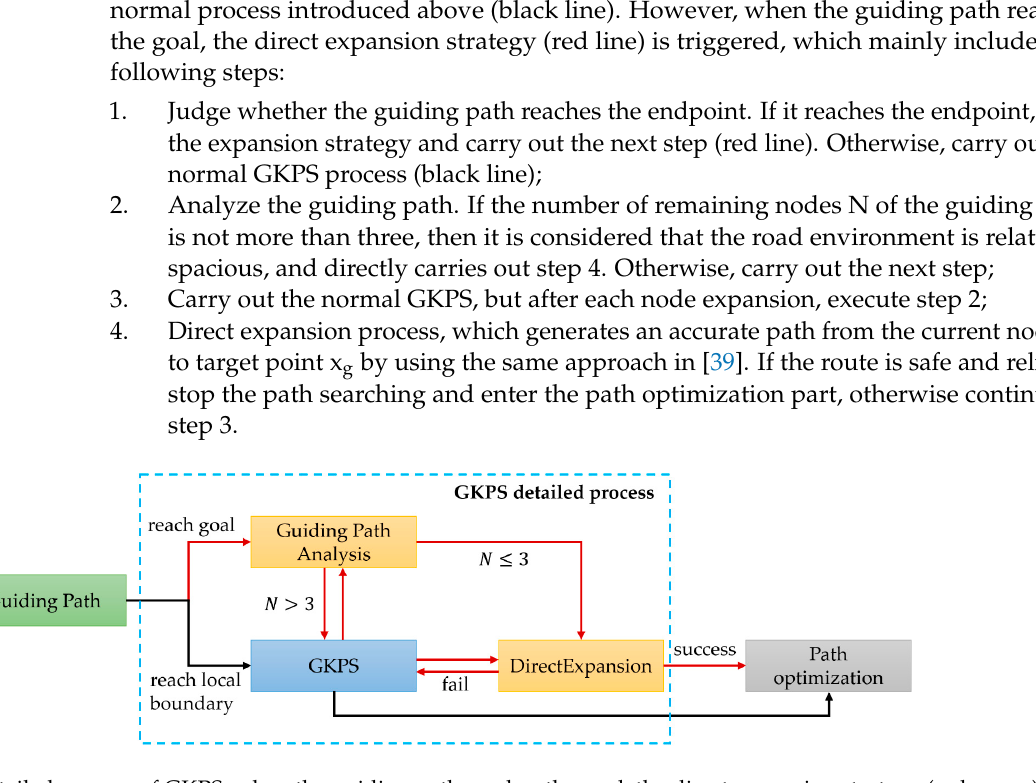
Figure 5. The detailed process of GKPS, when the guiding path reaches the goal, the direct expansion strategy (red arrow) is executed. Otherwise, GKPS executes the normal process (black arrow).